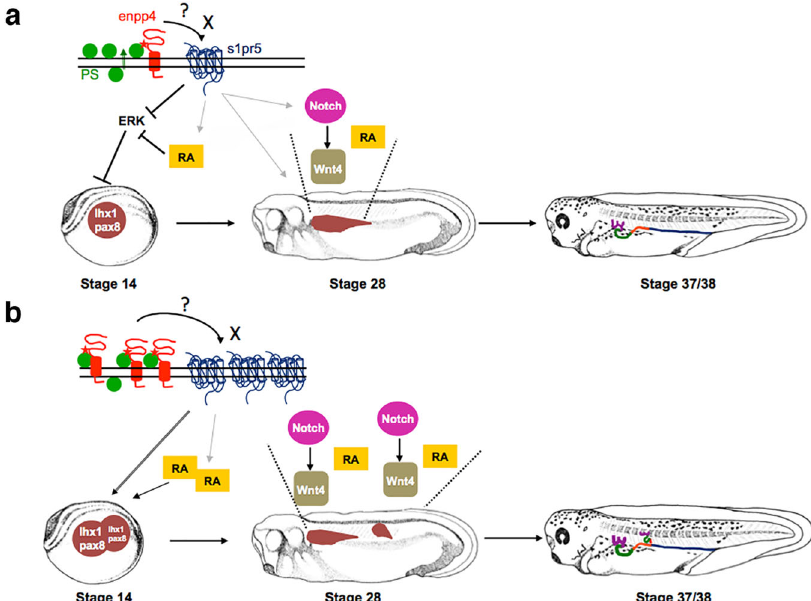
Fig. 8 Proposed model of how Enpp4/S1pr5 controls pronephros patterning. a During normal pronephric development, in the extracellular space, Enpp4 binds to phosphatidylserine close to, or in its catalytic site, which can then either interact with the S1pr5 or produce a novel ligand X, able to bind to this receptor. The activation of S1pr5 leads to the upregulation of lhx1/pax8 pronephric markers in the kidney fi eld either by acting upstream of RA signalling pathway or by acting directly via the ERK or calcium pathways. At later stages, RA is required for tubules morphogenesis and Notch and Wnt pathway are involved in the patterning of the pronephric tubules. The mechanism by which S1pr5 activation directs the expression domains of these genes remains to be con fi rmed. b Enpp4 and S1pr5 overexpression lead to expanded and ectopic expression domains for both the Notch and RA pathway genes and wnt4 . These changes in patterning gene expression domains induce the formation of enlarged pronephric segments and ectopic pronephric